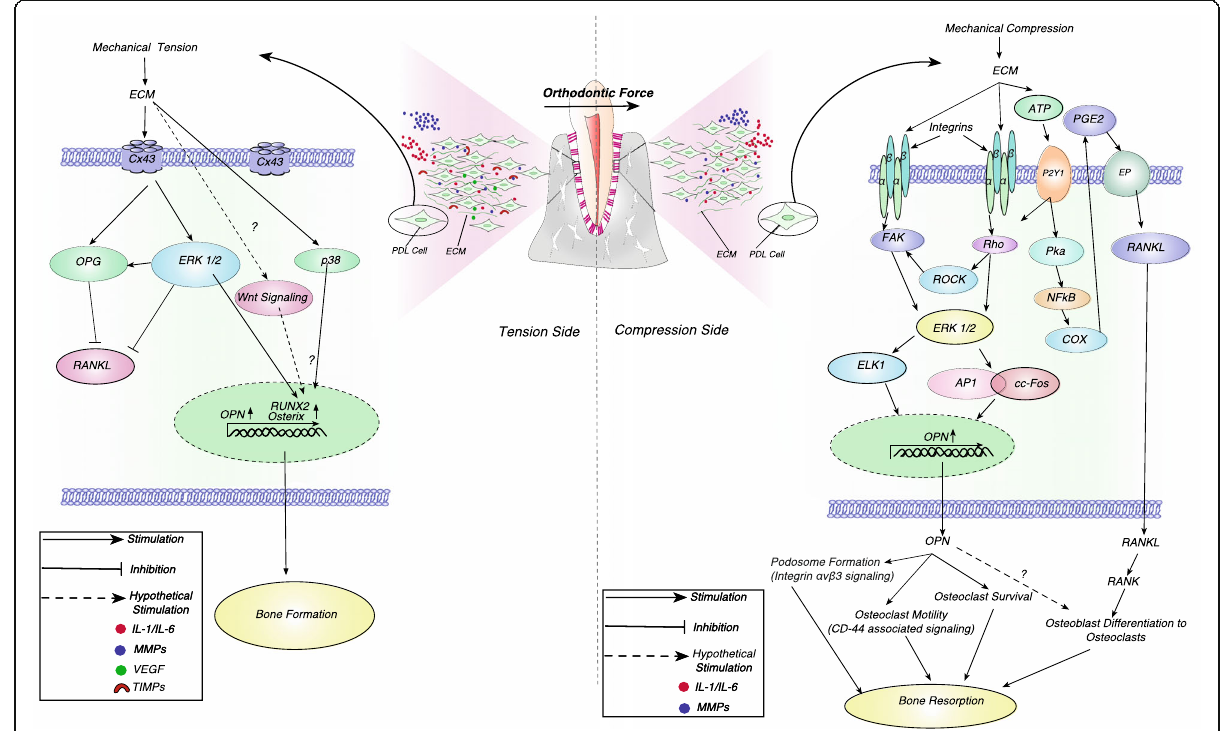
Fig. 3 A schematic representation of osteopontin regulation and osteopontin-mediated periodontal remodeling during orthodontic tooth movement at tension side and compression side. ECM (extra-cellular matrix), PDL (periodontal ligament), Cx43 (connexin 43), ERK1/2 (extra-cellular signal-regulated kinase 1,2), RUNX2 (runt-related transcription factor 2), IL-1/IL-8 (interleukin 1/8), MMP ’ s (matrix metalloproteinases), VEGF (vascular endothelial growth factor), TIMP ’ s (tissue inhibitors of metalloproteinases), ATP (adenosine triphosphate), PGE2 (prostaglandin E2), EP, RANKL (receptor activator of nuclear kappa-B ligand), RANK (receptor activator of nuclear kappa-B), OPG (osteoprotegerin), P2Y1 (purinoreceptor 1), Pka (protein kinase A), NFkB (nuclear factor kappa B), COX (cyclooxygenase), ROCK (Rho-associated protein kinase), FAK (focal adhesion kinase), ELK1 (ETS domain containing protein), AP1 (activator protein